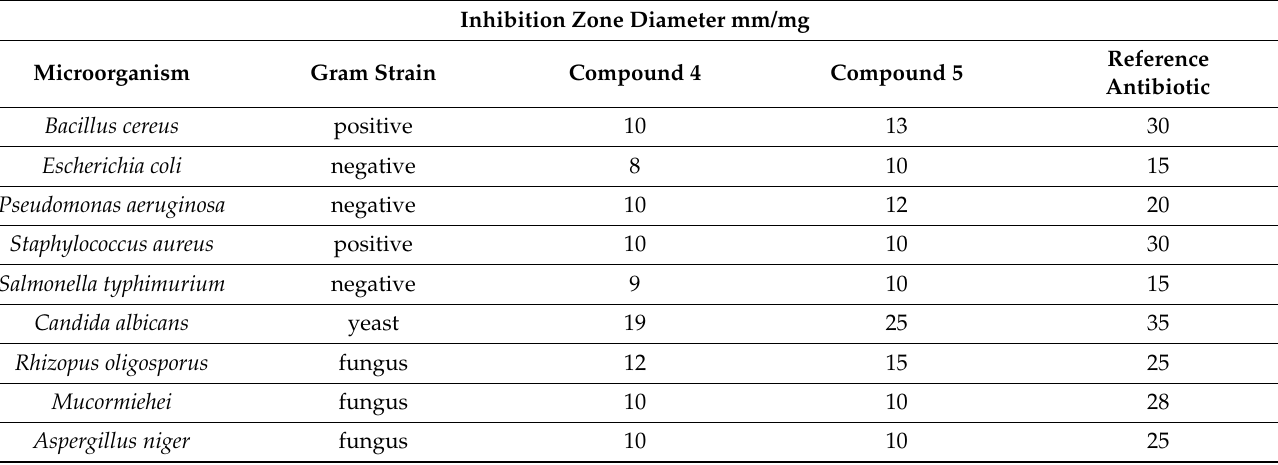
Table 3. The anti-bacterial and antifungal activities of the tested compounds 4 and 5.